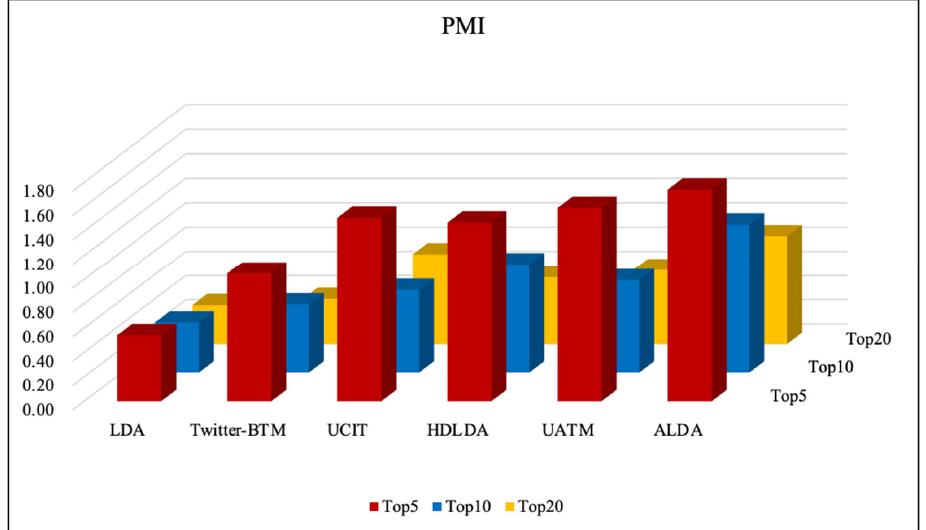
Figure 3. PMI score of each model on AOL query log dataset.